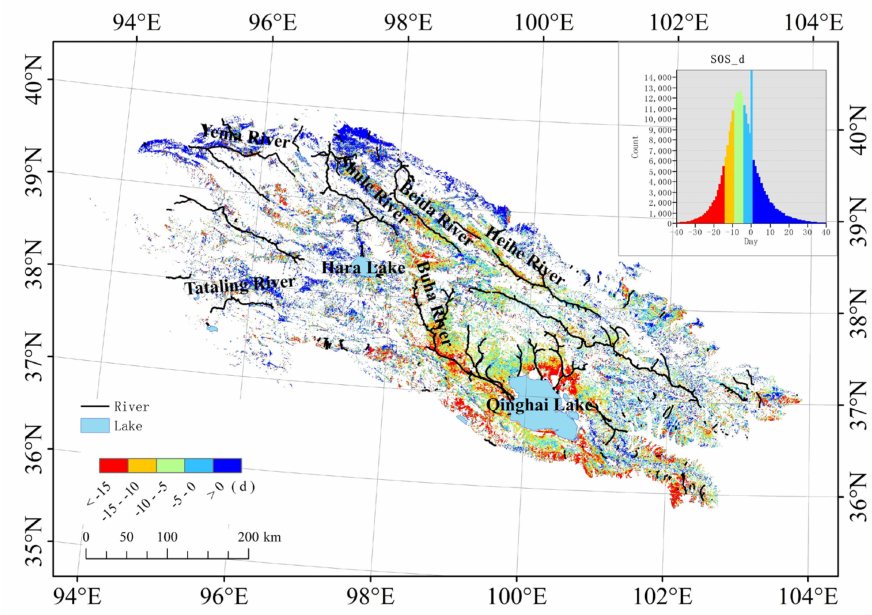
Figure 11. River network and D-Value of SOS in the study